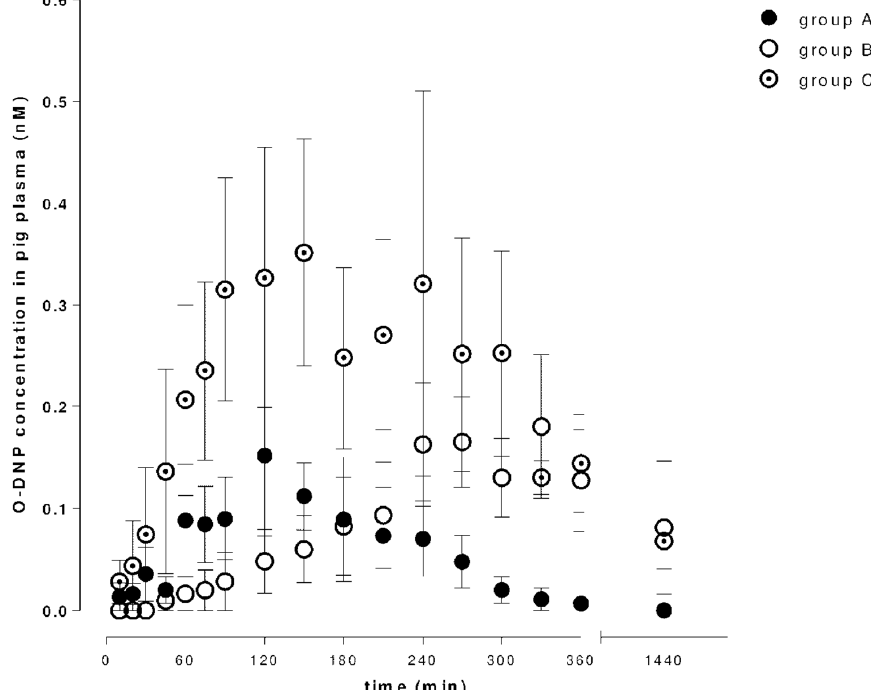
Figure 3. Concentrations of 6- O -desmethyldonepezil (O-DNP) in porcine plasma after a single intragastric dose of donepezil (5 or 10 mg; day 1), and after a dextran sodium sulfate (DSS)-induced gastrointestinal injury (10 mg dose of donepezil; day